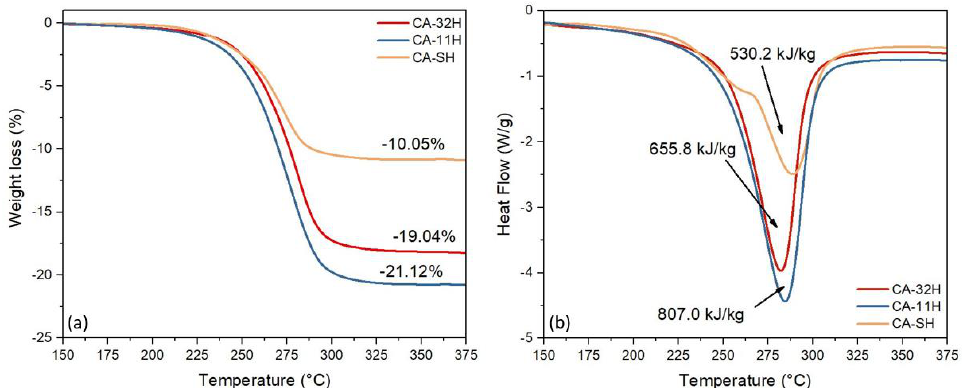
Figure 7. CA-32H (red), CA-11H (blue) and CA-SH (orange) thermogravimetric (TG) ( a ) and differential scanning calorimetry (DSC) ( b ) curves, recorded between 150 °C and 375 °C, scan rate 10 °C/min.